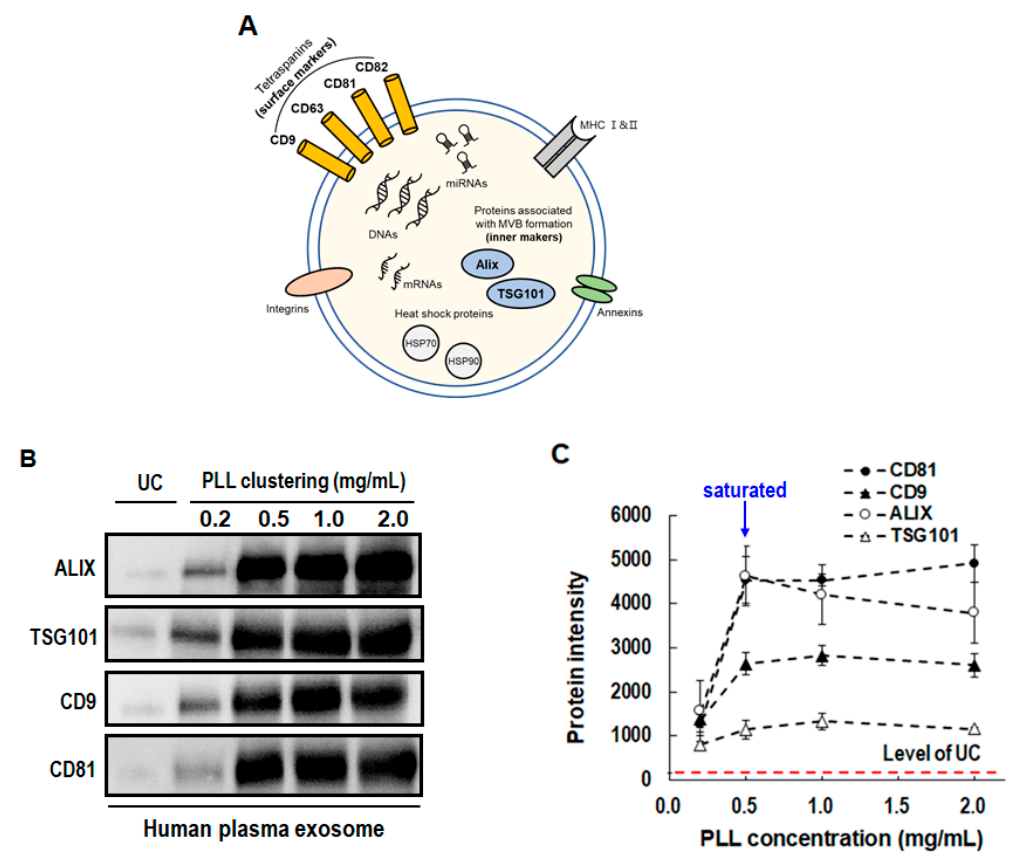
Figure 4. Detection of EV surface protein markers (CD81 and CD9) and inner protein markers (ALIX and TSG101) according to PLL concentration (0.2–2.0 mg/mL). ( A ) Diagram of molecular composition in EVs. ( B ) Band images of Western blot assay. ( C ) Band intensity of four EV markers. (PLL: poly-l-lysine, GuTc: guanidium thiocyanate).